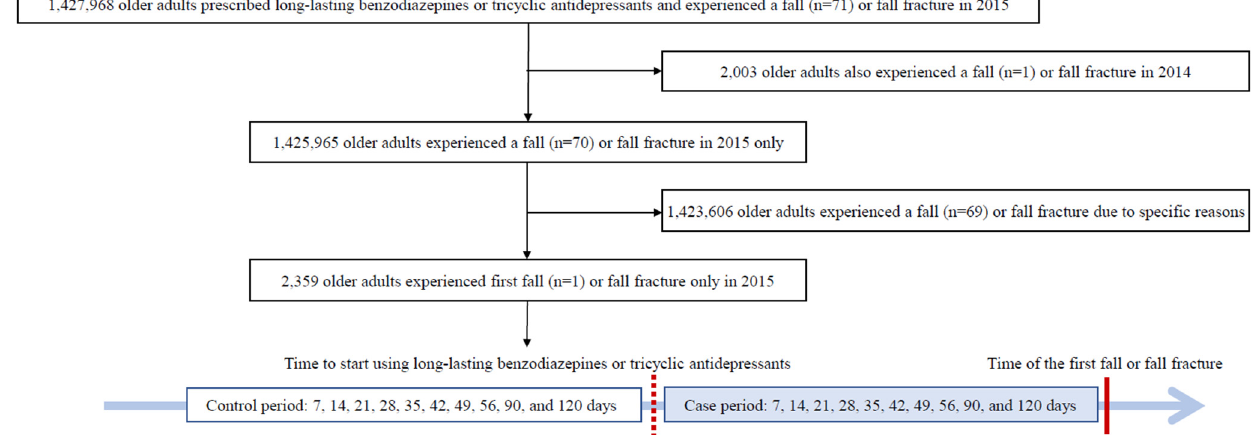
Figure 1. Flow chart of the case and control days selection by case-crossover design.